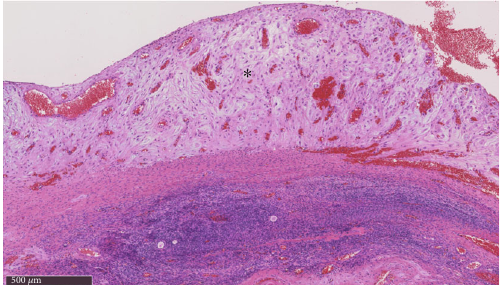
Figure 3: Microscopic view of a mural nodule (hematoxylin and eosin staining, magni fi cation: 100x). Edematous tissue with abundant stromal cells ’ cytoplasm is visible (asterisk). These fi ndings are consistent with